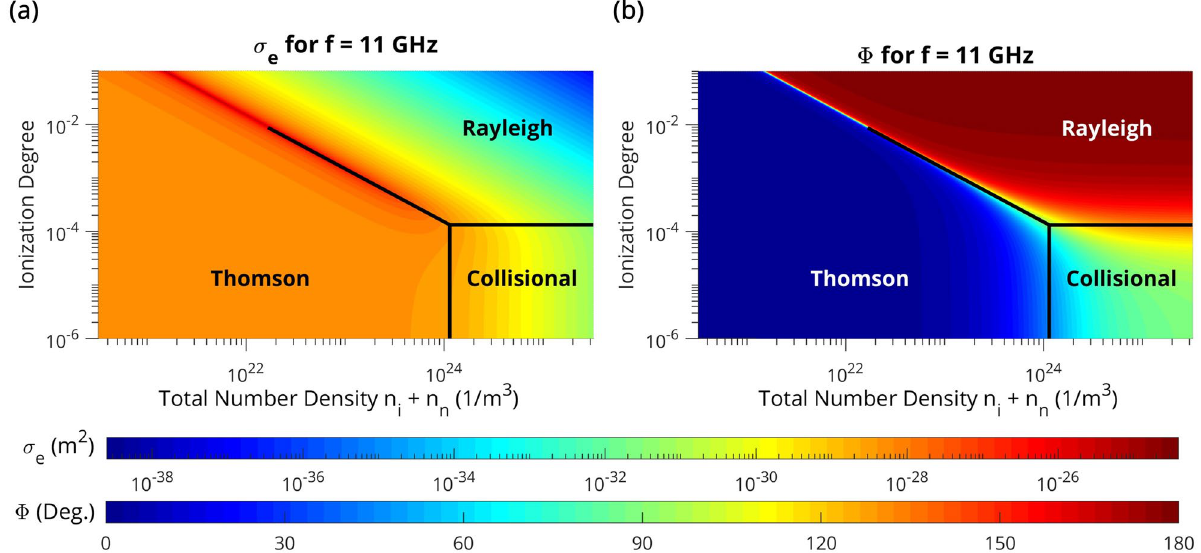
Figure 1. Scattering regimes. Contour plots for f = 11 GHz ( a ) total individual electron scattering cross-sections σ e —calculated from Eq. 7 and ( b ) phase-lag between electron displacement and the incident microwave field—calculated from Eq. 5. The corresponding scattering regimes (Thomson, collisional, and Rayleigh) are additionally depicted. An air-based, singly ionized short/thin plasma ellipsoid with electron temperature T e = 0.9 eV (relevant to the considered experimental plasmas) and depolarization factor ξ